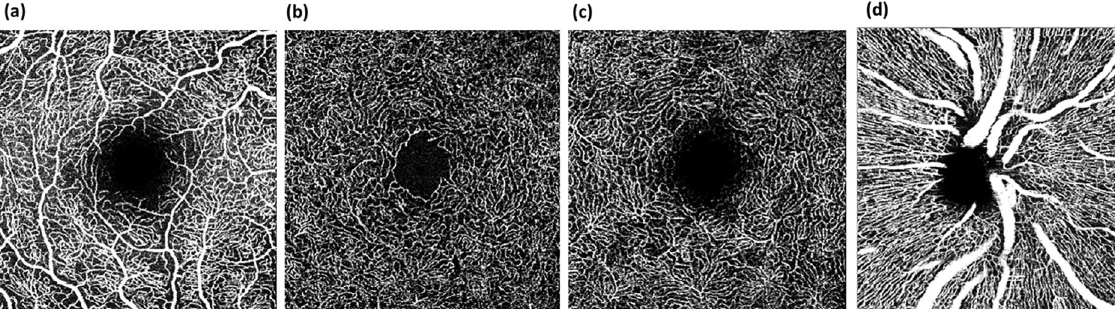
Fig 1. OCT-A images of the macula with superficial vascular plexus (SVP, a), intermediate capillary plexus (ICP, b) and deep capillary plexus (DCP, c) as well as peripapillar region (d).